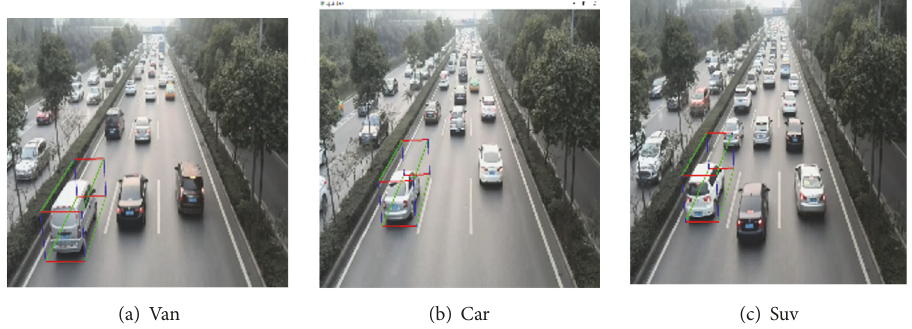
Figure 29: A rough three-dimensional model frame.